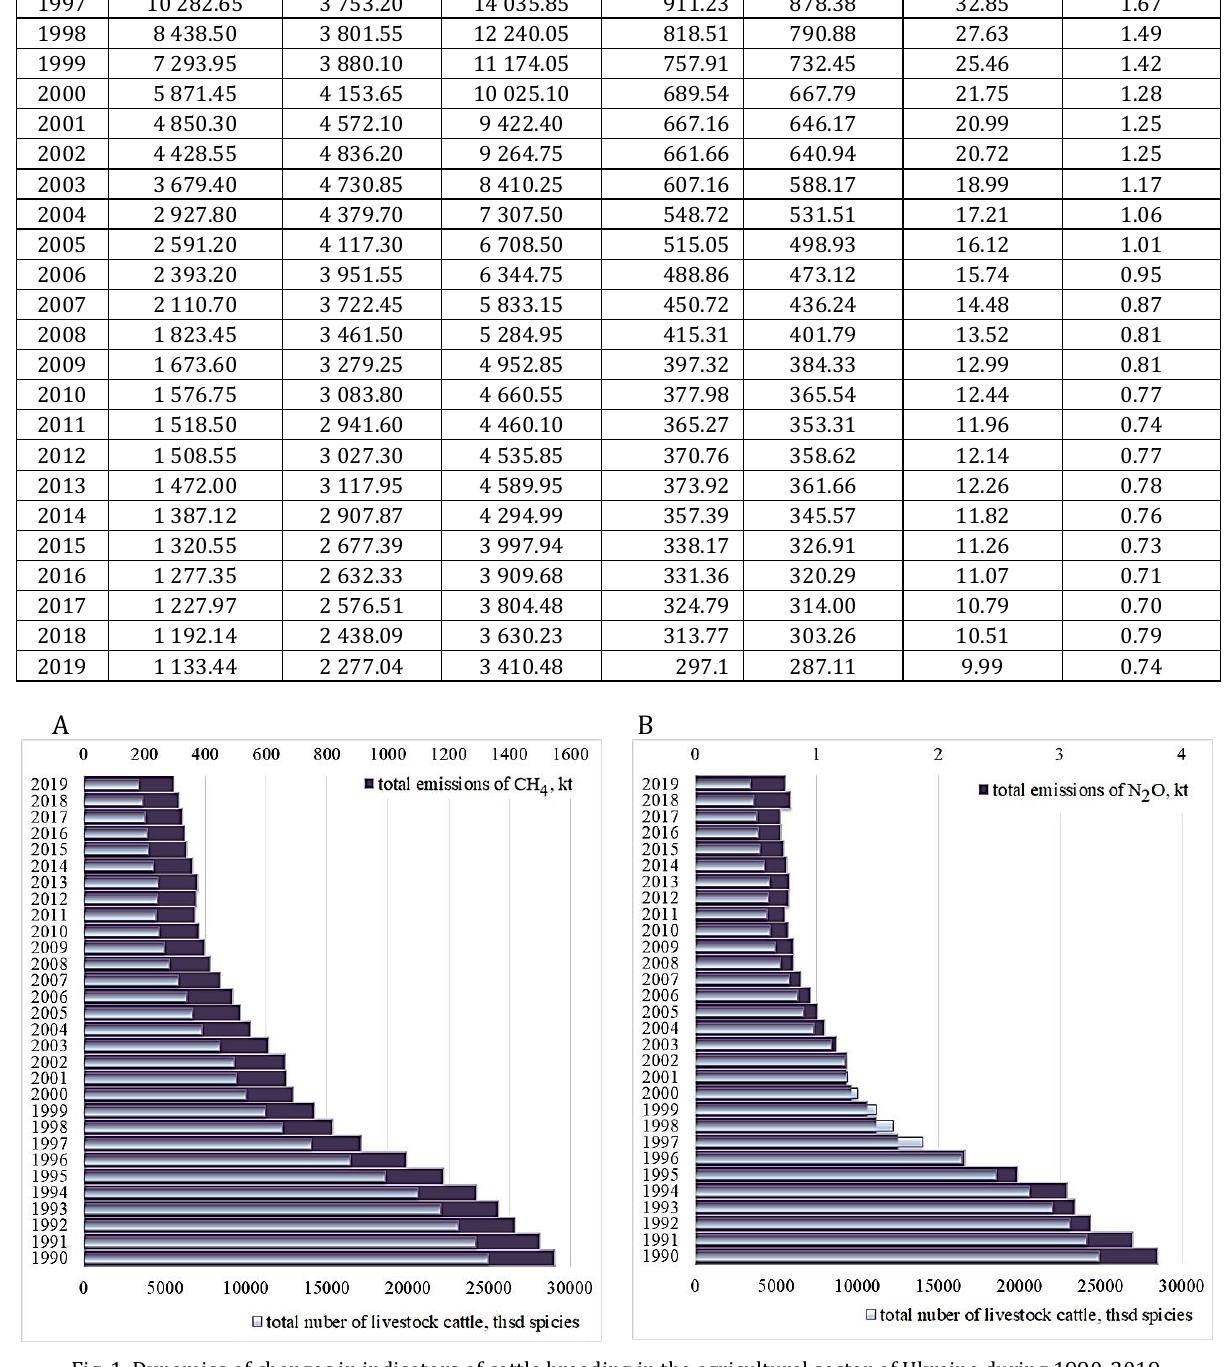
Fig. 1. Dynamics of changes in indicators of cattle breeding in the agricultural sector of Ukraine during 1990-2019: A) methane emissions; B) nitrogen oxide